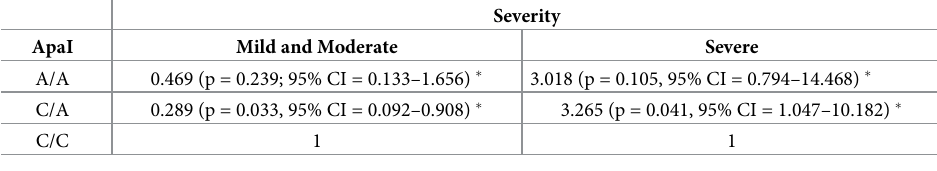
Table 4. Hazard ratios for ApaI +64978C > A genotypes by severity at first